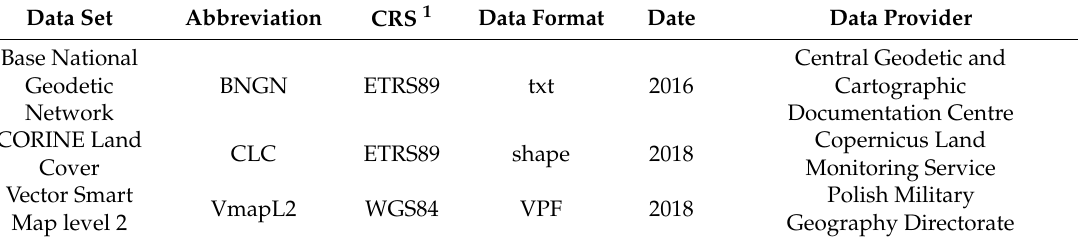
Table 1. Spatial data